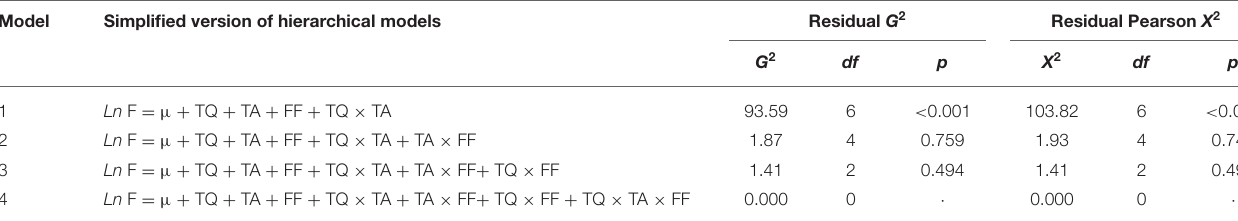
TABLE 9 | Logit model analysis of proportional focus of feedback by type of question and type of answer in I-R-F interactions.